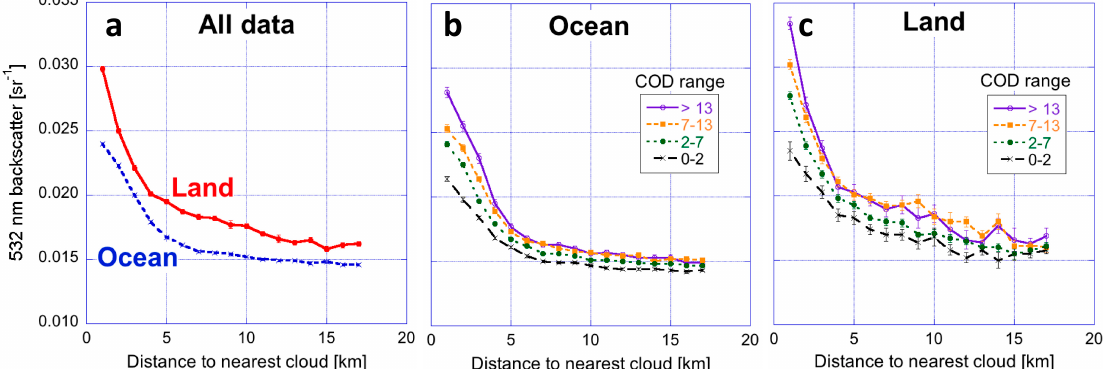
Figure 3. Mean vertically integrated lidar backscatter, plotted as a function of distance to clouds. ( a ) All data (Data used are available at Table S2); ( b ) Data for various ranges of the maximum nearby cloud optical depth (COD) over ocean (Data used are available at Table S3); ( c ) Same as Panel b, but over land (Data used are available at Table S4). Fraction of used CALIOP columns (in %) that fall into each COD range plotted in Figures 3b and 3c is available at Table S11.